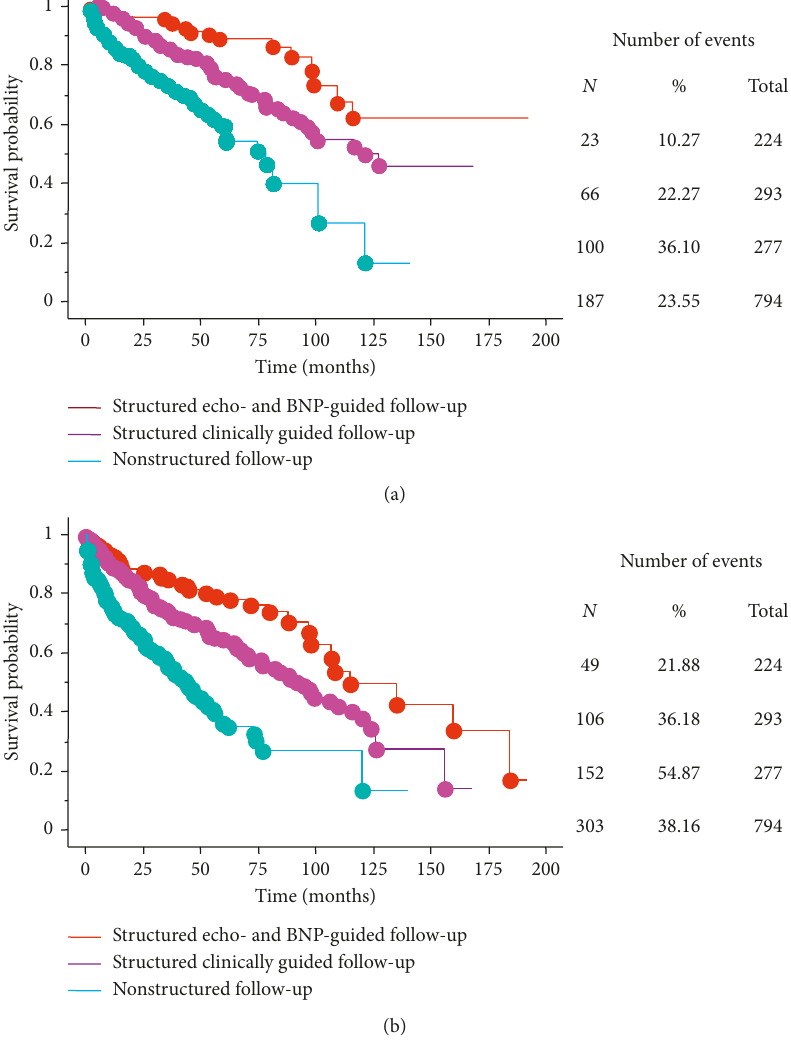
Figure 3: (a) Survival free from all-cause mortality in patients of the echo- and BNP-guided follow-up, in patients of the clinically driven 0 . 0001). (b) Survival curves for the combined end point of death follow-up, and in those who received no specific follow-up care ( X 2 53.5; p or hospitalization for worsening heart failure in echo- and BNP-guided and symptom-guided groups and in patients who received no specific follow-up care ( X 2 72.4; p 0 . 0001). When compared to patients of the symptom-guided group and those who did not receive any < organized follow-up care, life was estimated to be prolonged by an average of 2.5 years and 4 years, respectively, by the echo- and BNP- guided strategy. Similar results were attained with the event-free life <